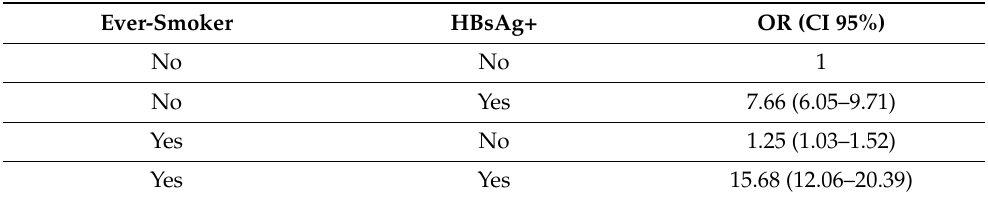
Table 2. Evidence for the additive and multiplicative interaction of the contemporary presence of smoking and HBV infection on the risk of HCC development (adapted from